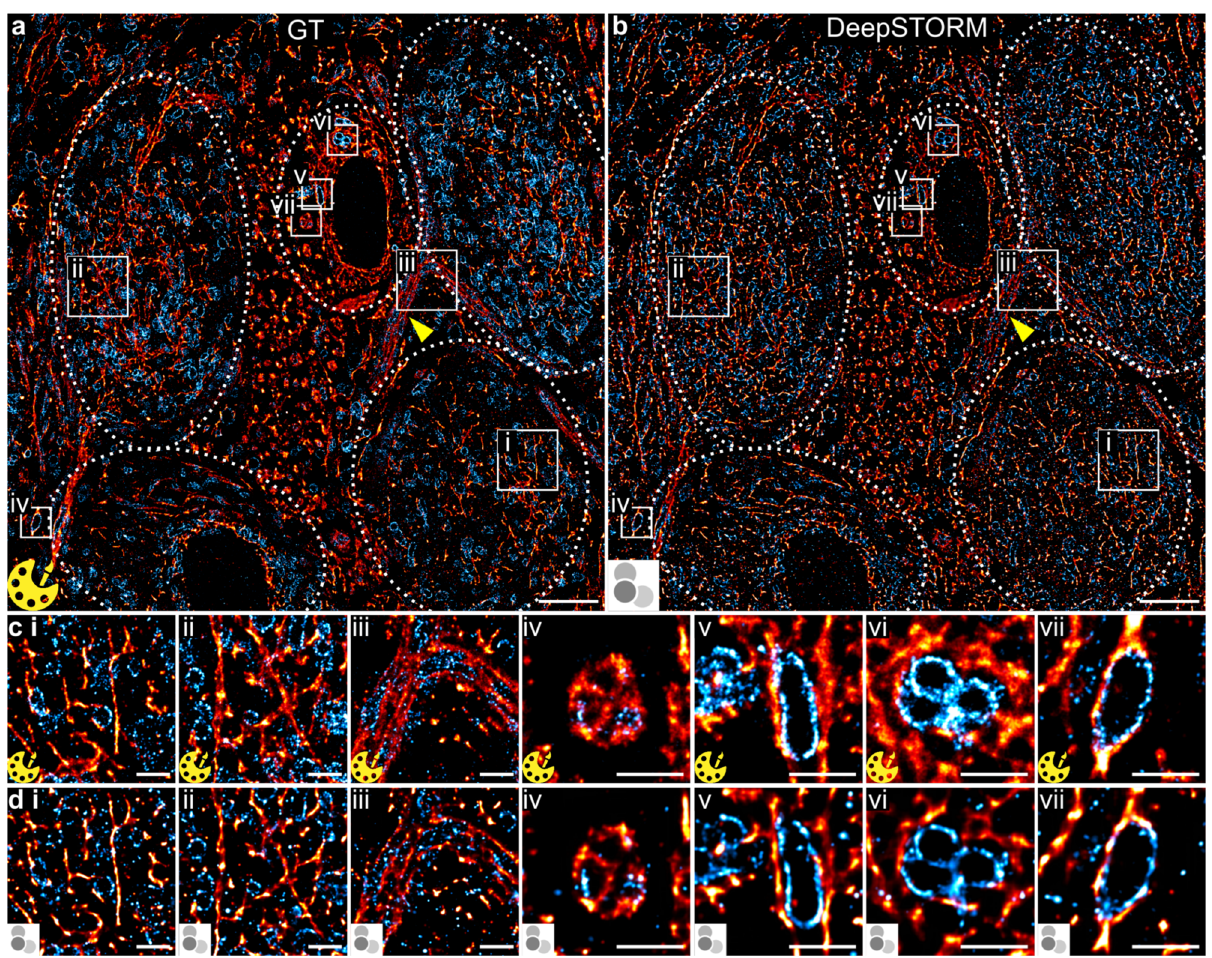
Fig. 2 | Comparison between Exchange-PAINT super-resolution images of ground truth (GT; yellow Picasso icon) and DeepSTORM predicted images (DeepSTORM icon) in an MNTB tissue section. a , b Tissue sample labelled for α - tubulin (red; P1 imager strand) and TOM20 (cyan; P5 imager strand) containing 5 cells(dottedlines)renderedasa( a )GTimage(0.5nMimagerstrandsP1,P5;10,000